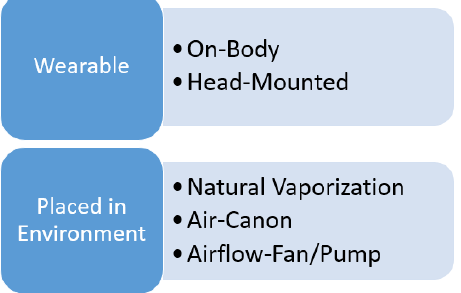
Figure 1. Categories of olfactory displays.